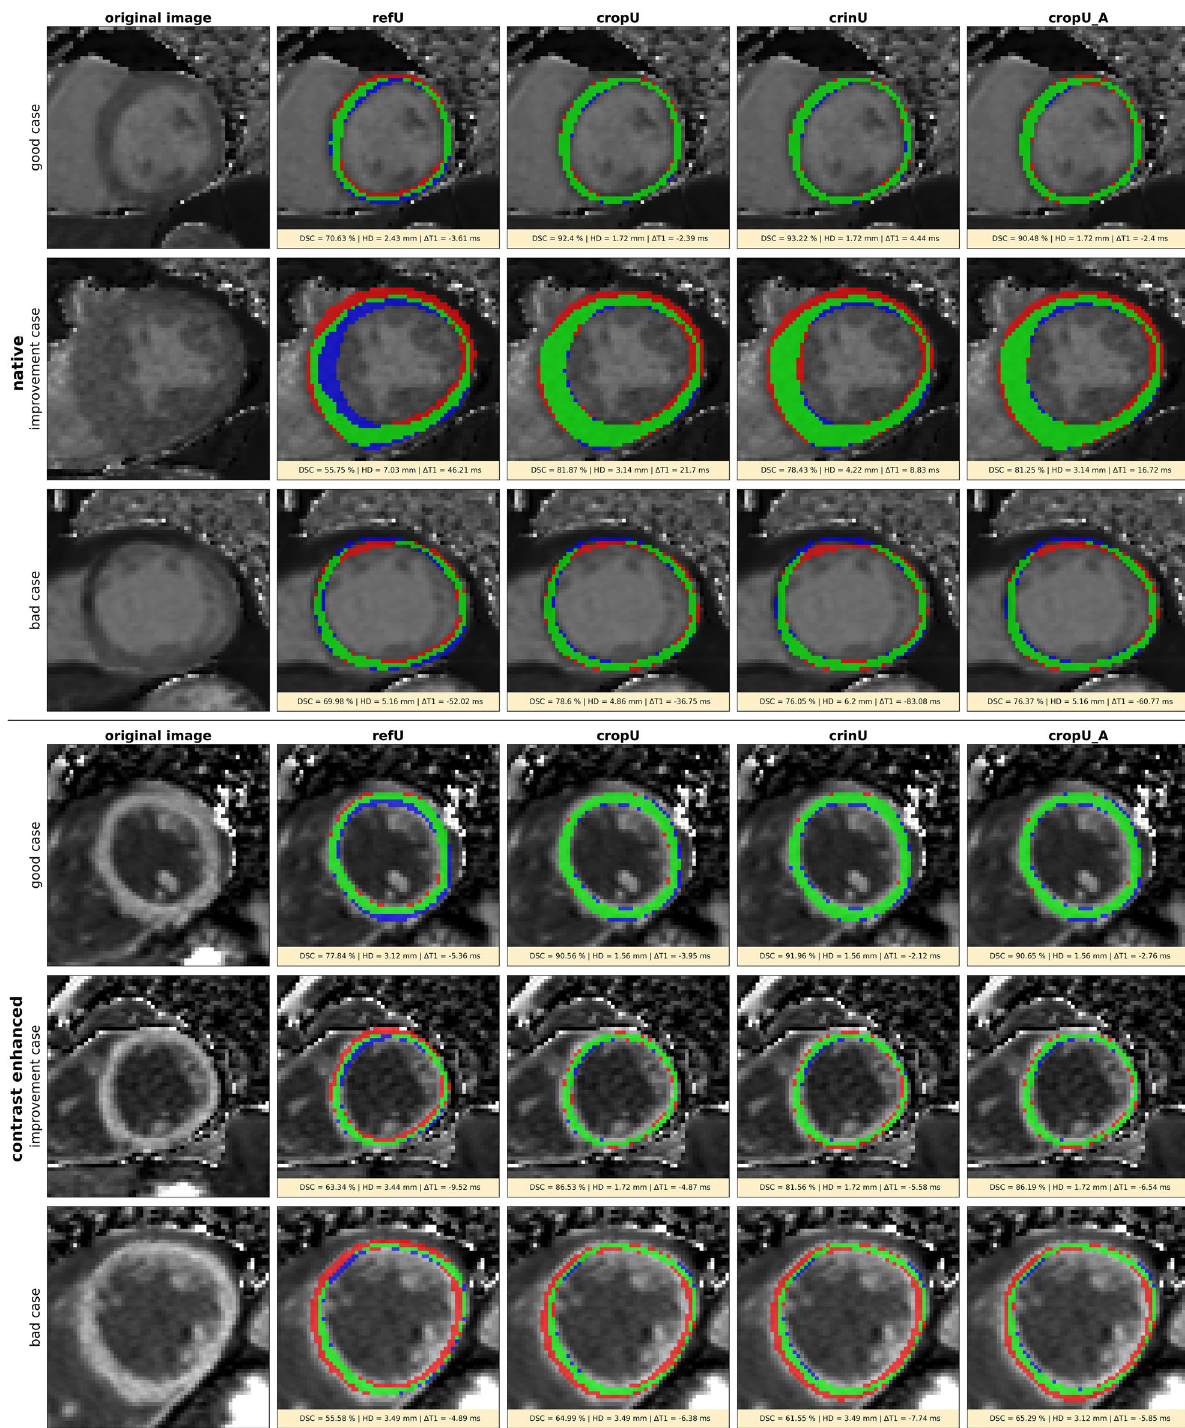
Figure 3. Example results of the automated segmentation in refU, cropU, crinU and cropU_A. The first column shows the original image, the second column the refU segmentation, the third column the cropU segmentation, the fourth column the crinU and the fifth column the cropU_A segmentation. The upper block corresponds to native and the lower block to contrast enhanced data; respectively in each block the first row shows a fairly good case across all four pipelines, the second row shows a case that is improved in cropU and crinU compared to refU and the third row shows a poor case across all four pipelines. Green denotes true positive, blue false negative and red false positive segmented